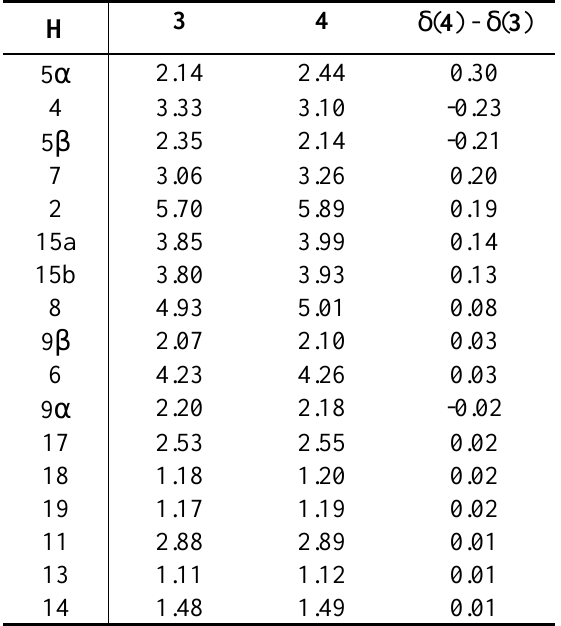
Table 1. 1 H NMR chemical shifts (ppm) of isomers 3 and 4 .